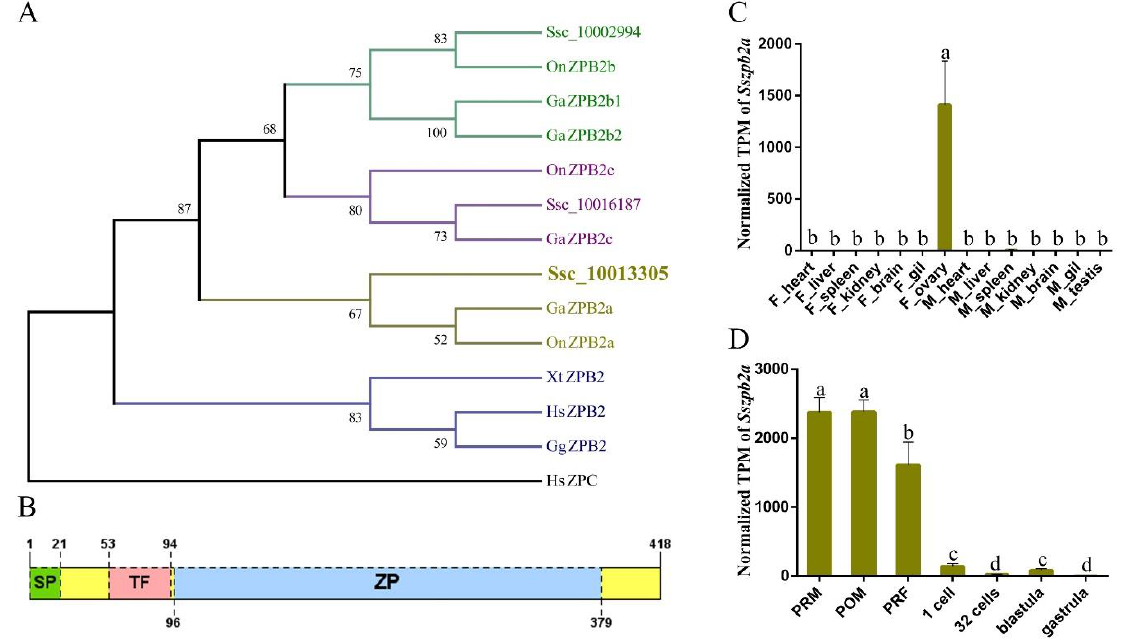
Figure 1. Evolutionary analysis of SsZPB2a and its expression analysis in the adult tissues and embryonic stages at the mRNA level. ( A ) Phylogenetic analysis of the vertebrate ZPB2 family members. Full lengths of the ZPB2 were analyzed by the neighbor-joining method using the MEGA7 program. Bootstrap values derived from 1000 runs are shown. Homo sapiens (Hs) ZPC protein is used as an outgroup. Accession numbers for the sequences used are as follows: Hs (ZPB2, NP_067009.1; ZPC, NP_001103824.1); Gallus gallus , Gg (ZPB2, NP_990210.1); Xenopus tropicalis , Xt (ZPB2, XP_002939919.1); Oreochromis niloticus , On (ZPB2a, XP_003438185.1, ZPB2b, XP_025764228.1, ZPB2c, XP_025765046.1); Gasterosteus aculeatus , Ga (ZPB2a, XP_040026904.1, ZPB2b1, XP_040019940.1, ZPB2b2, XP_040019940.1, ZPB2c, ENSGACP00000016351.1). ( B ) Location information of conserved domain of SsZPB2a. ( C ) The expression of Sszpb2a1 in adult tissues (n = 3). ( D ) The expression of Sszpb2a1 in embryonic stages (n = 3 for ovaries at each developmental stage, n = 30 for each embryonic stage). Normalized TPM values were used for plotting. TPM, transcripts per kilobase of exon model per million mapped reads. Values with different low letters indicate statistical significance ( P < 0.05) after one-way ANOVA analysis.